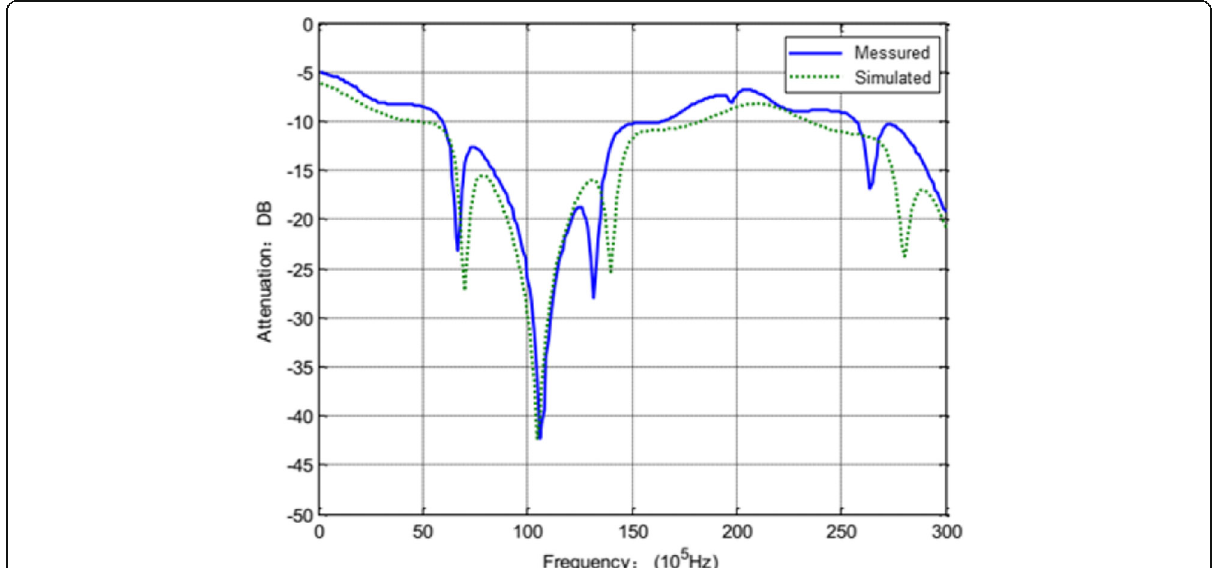
Fig. 9 Laboratory test and simulation results of amplitude-frequency characteristic